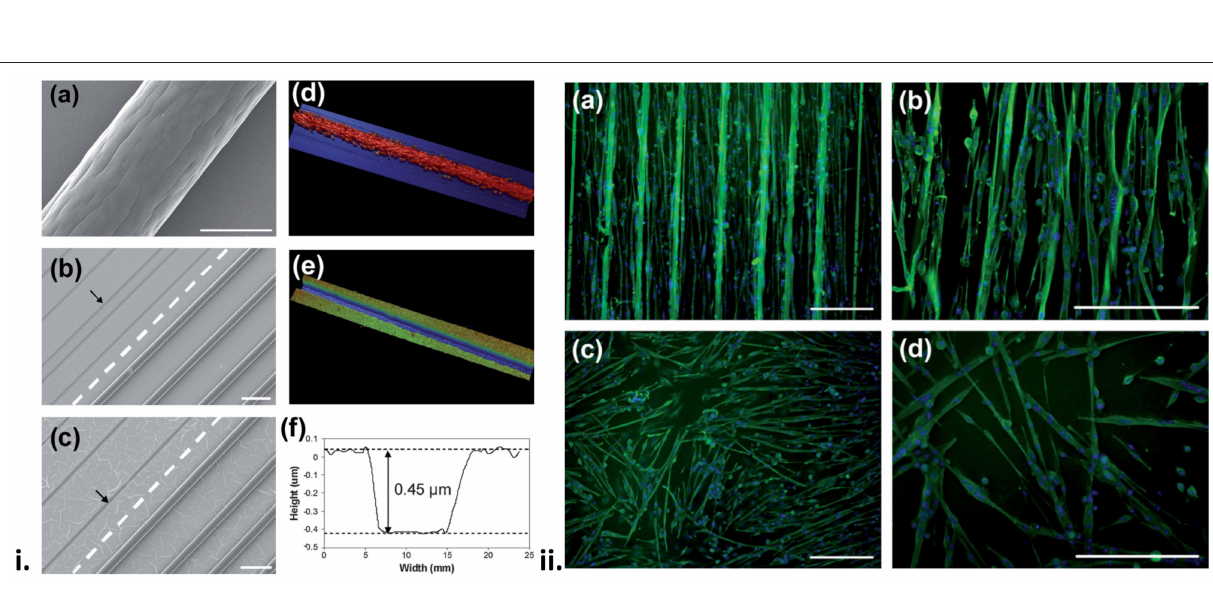
Frontiers in Medical Technology |